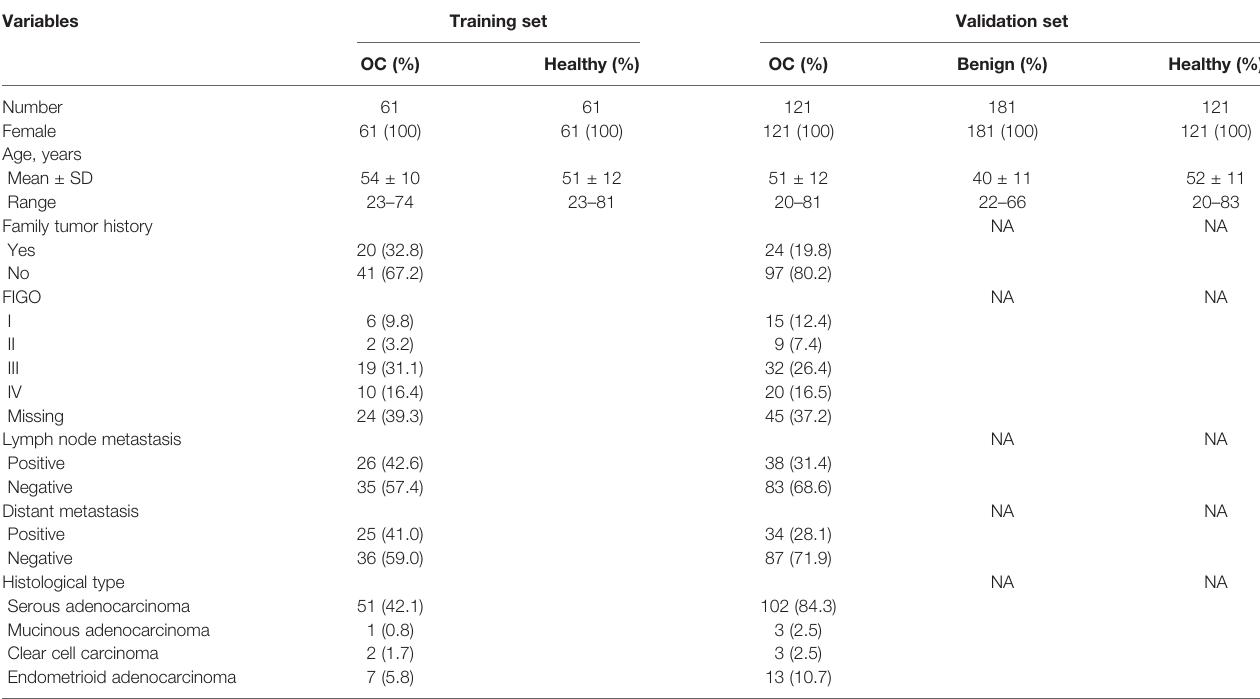
TABLE 1 | Characteristics of study